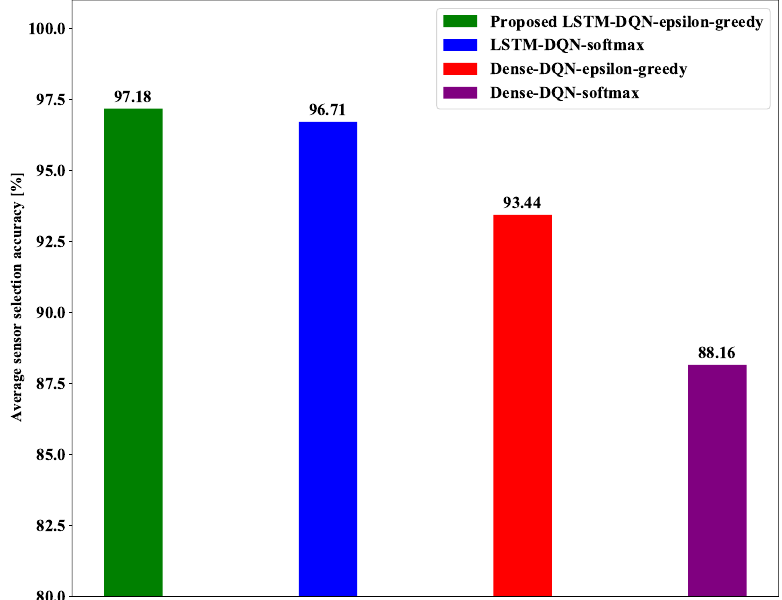
Figure 12. Average best sensor selection